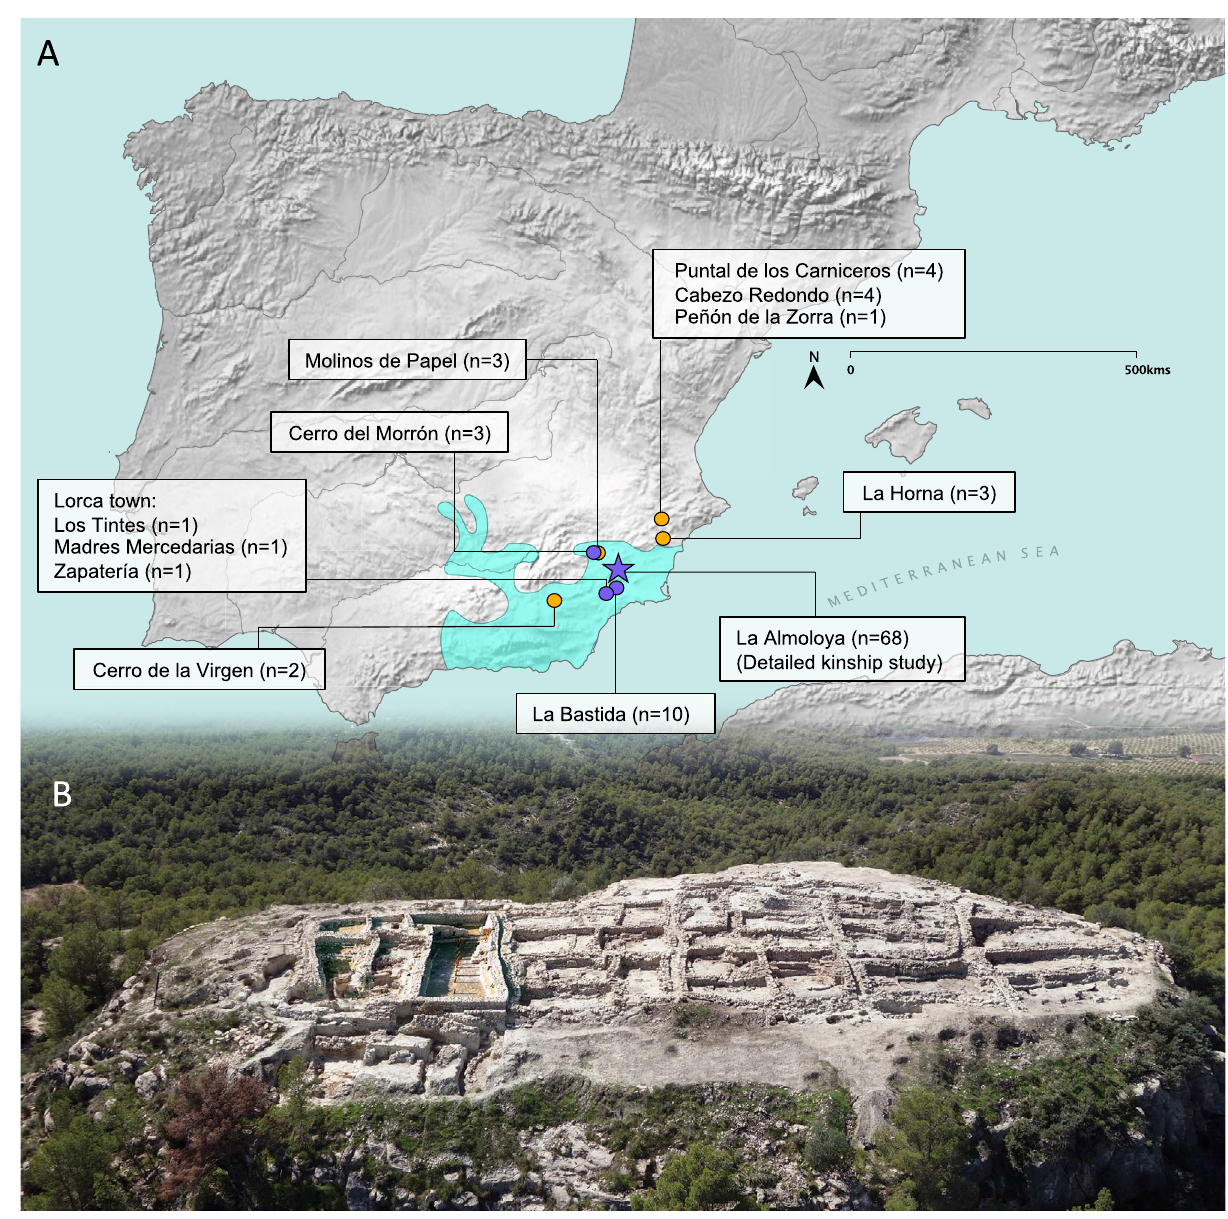
Figure 1. Early bronze age El Argar in southern Iberia. ( A ) Map of Iberia and location of the Argaric and other Bronze Age nearby sites. The map was created using QGIS 3.12 (https:// qgis. org/ en/ site/) and uses Natural Earth vector map data from (https:// www. natur alear thdata. com/ downl oads/). ( B ) A view of the La Almoloya hilltop site from the